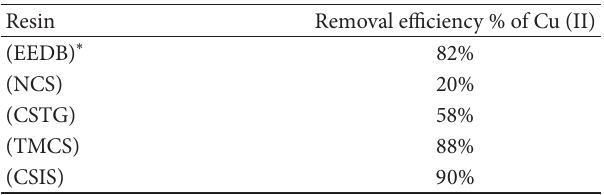
Table 2: Comparison of removal efficiency % of Cu (II) with dif- ferent